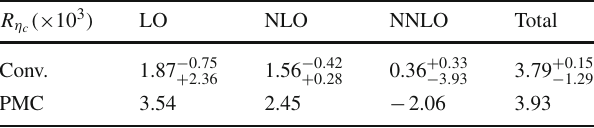
Table 2 Contributions from each loop term for R η NNLO level (in unit: × 10 3 ) under conventional and PMC scale-setting approaches. The central values are for μ r = 2 m c , and the errors are for μ